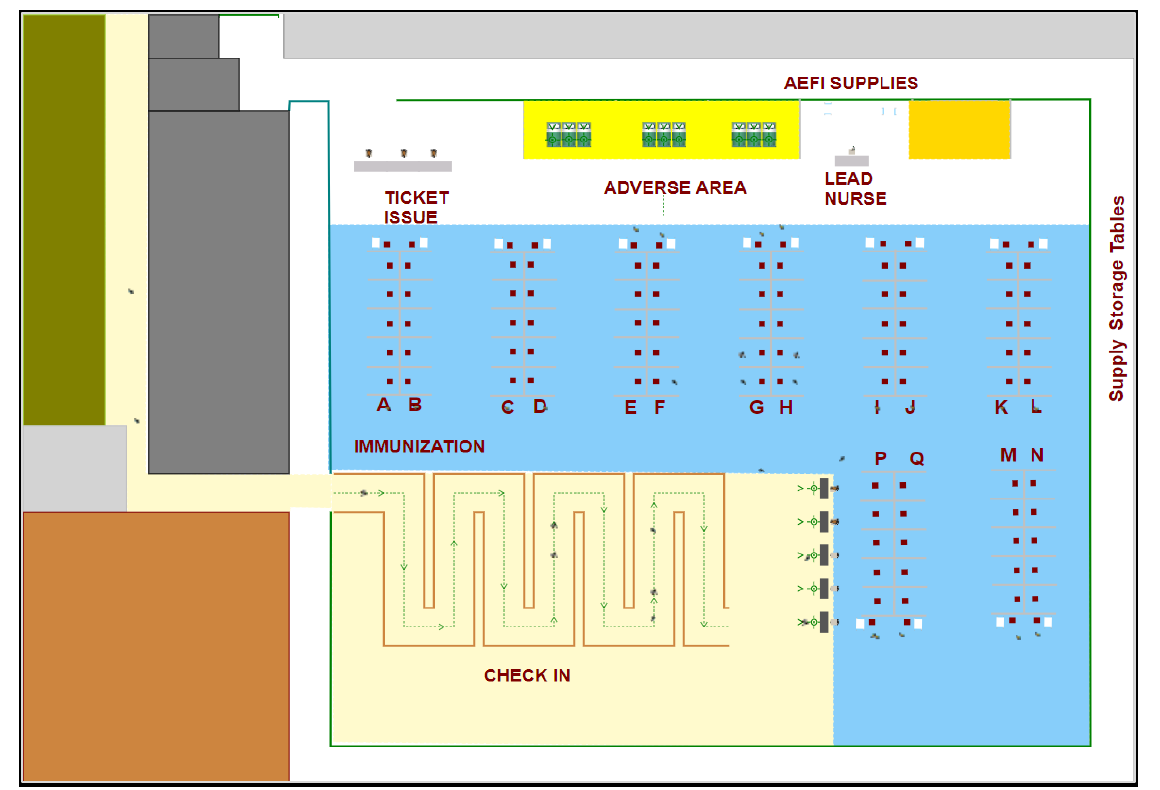
Figure 2. 2D physical layout of a hockey hub vaccination clinic in two dimensions.